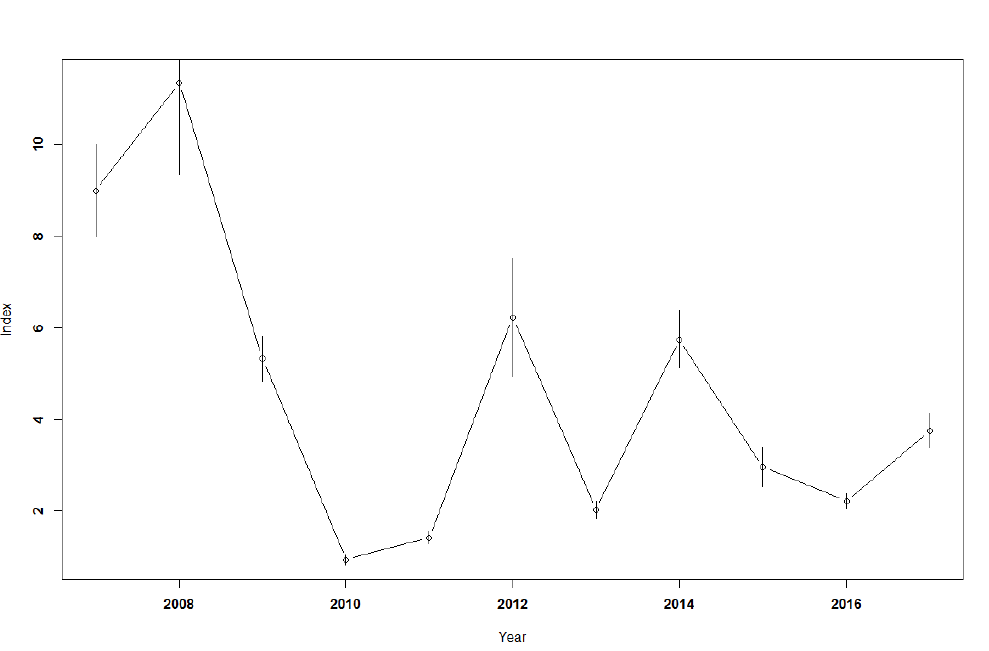
Figure 40. Index of relative abundance of horseshoe crab (delta mean catch per tow) developed from the fall portion of NEAMAP for the New York region with 95% confidence intervals.